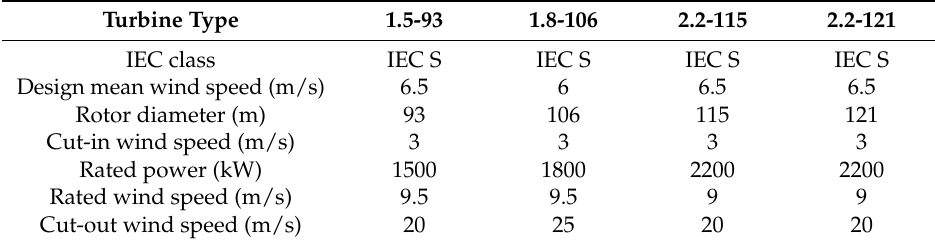
Table 4. Specifications of the low wind speed wind turbines developed by Envision